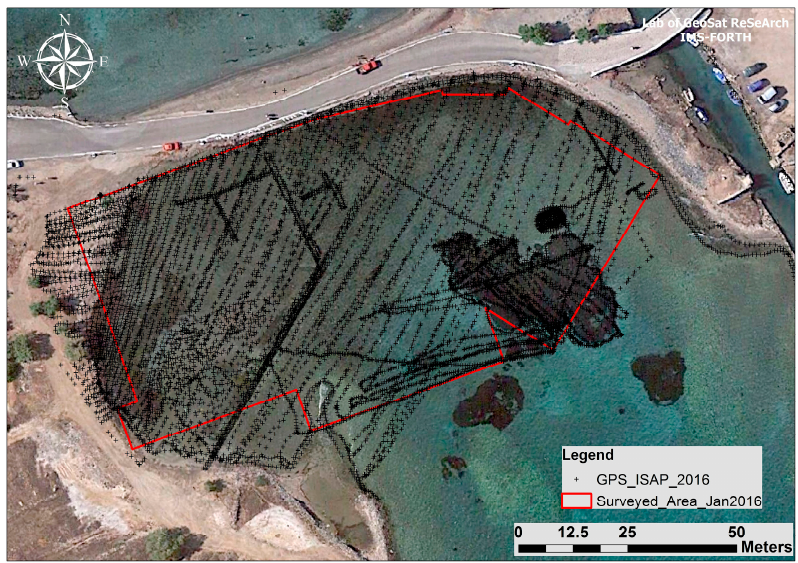
Figure 3. Spatial distribution of the points collected with the GNSS rover unit in the bay of Olous. These points were used to compile the bathymetry model of the bay. The red polygon outlines the area covered with the Electrical Resistivity Tomography method.